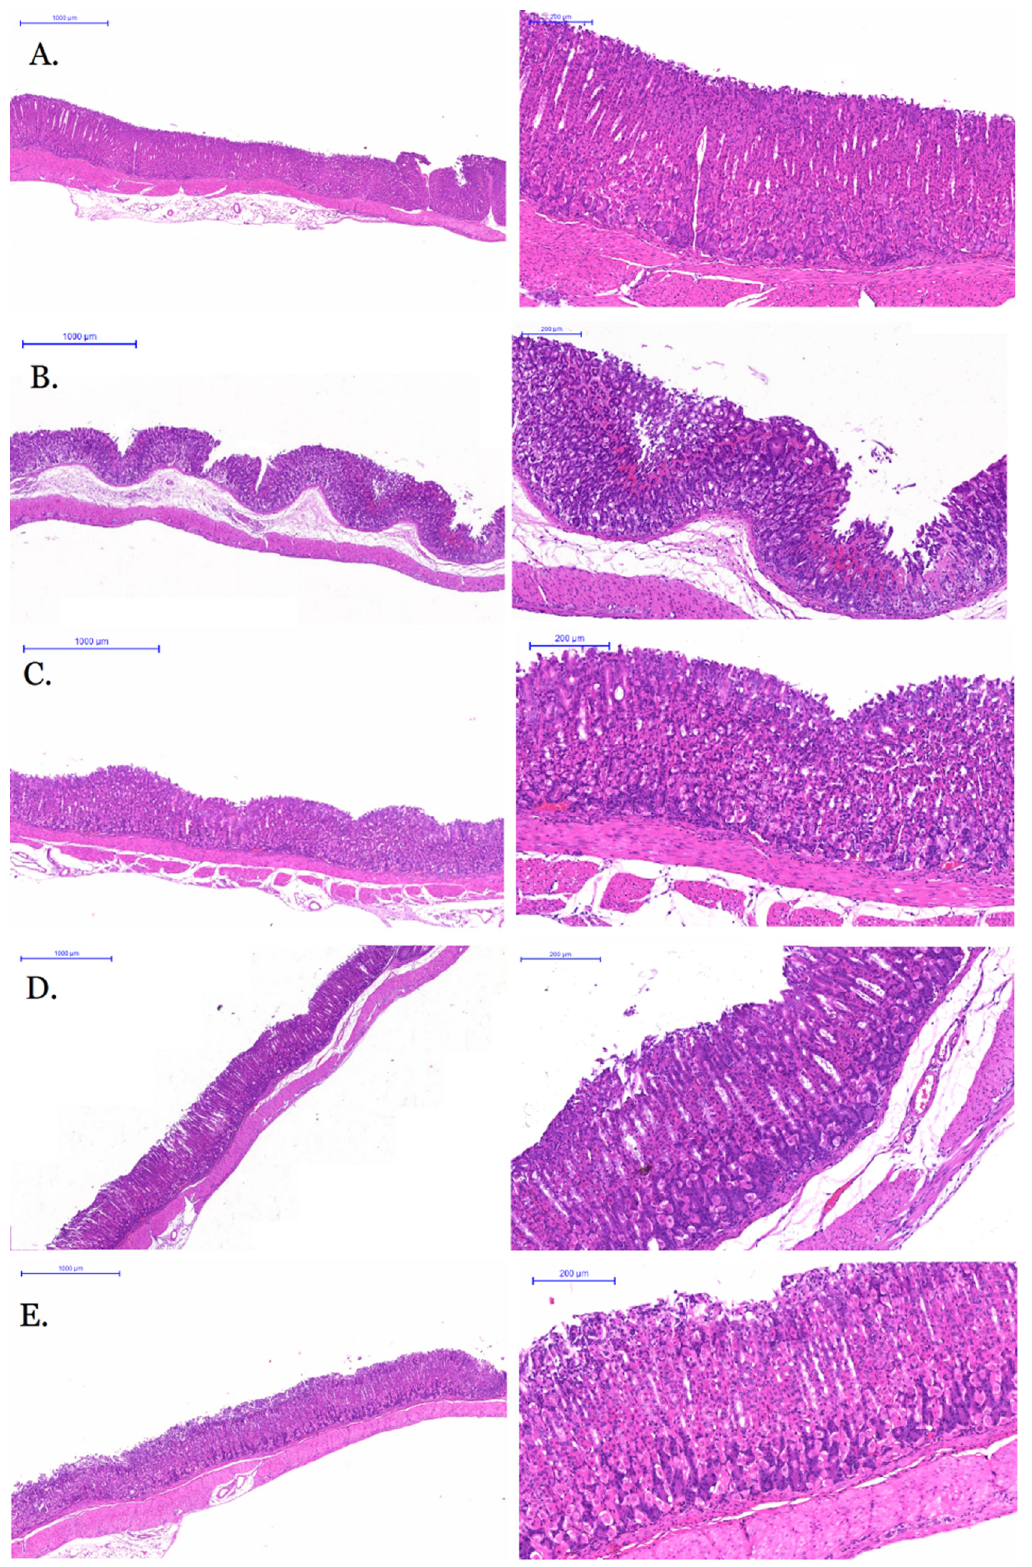
Figure 7. Morphological section of mouse gastric tissue of ( A ) control group, ( B ) model group, ( C ) GRR-CDs high-dose group, ( D ) GRR-CDs medium-dose group and ( E ) GRR-CDs low-dose